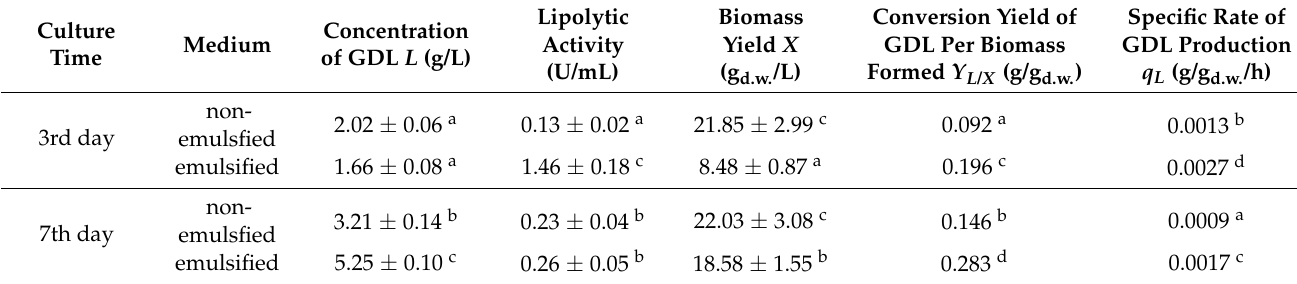
Table 1. Effect of the emulsification of the medium on growth and catalytic activity of the yeast Yarrowia lipolytica . Culture Time